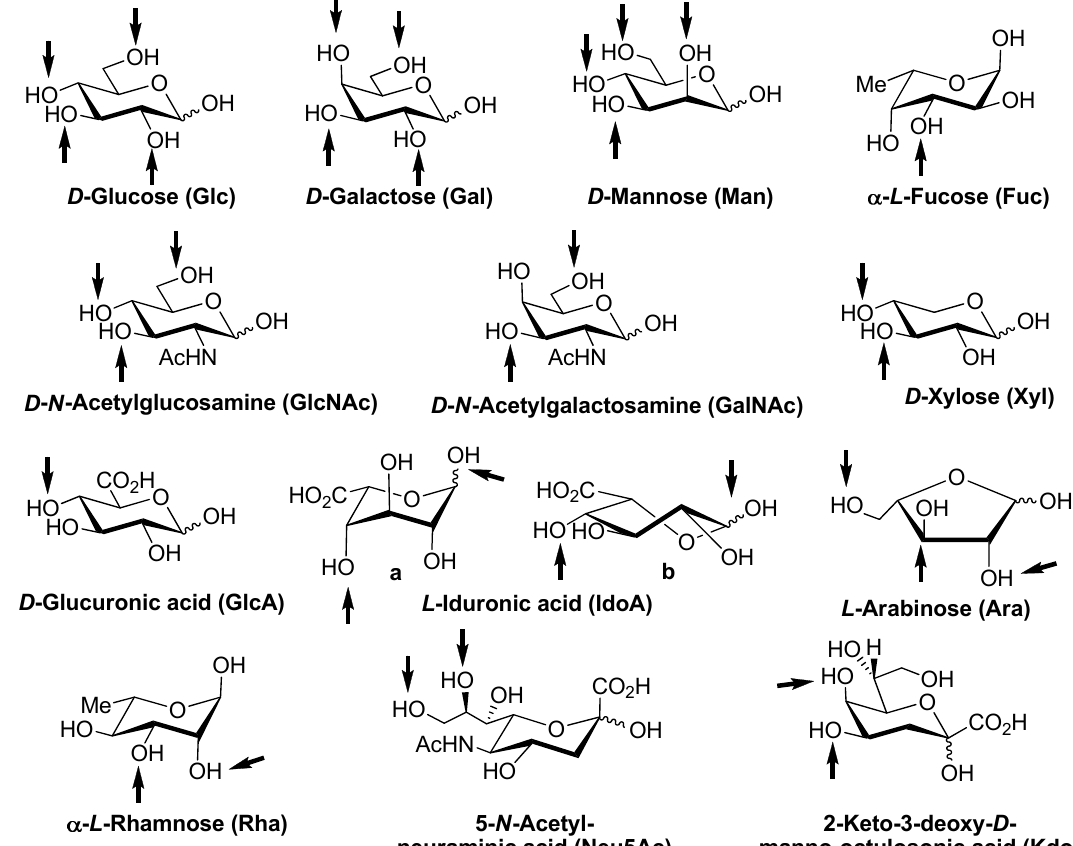
Figure 1. Illustration of the alphabet of the sugar language. Structural representation, name and symbol as well as the set of known acceptor positions (arrows) in glycoconjugates are given for each letter. Four sugars have L -configuration: fucose (6-deoxy- L -galactose), rhamnose (6-deoxy- L -mannose) and arabinose are introduced during chain elongation, whereas L -iduronic acid (IdoA) results from post-synthetic epimerization of glucuronic acid at C-5. The 1 C 4 conformation of IdoA ( a ) is in equilibrium with the 2 S 0 form ( b ) in glycosaminoglycan chains, where this uronic acid can be 2-sulfated. All other letters are D -sugars. Neu5Ac, one of the more than 50 sialic acids, often terminates sugar chains in animal glycoconjugates. Kdo is a constituent of lipopolysaccharides in the cell walls of Gram-negative bacteria and is also found in cell wall polysaccharides of green algae and higher plants. Foreign to mammalian glycobiochemistry, microbial polysaccharides contain the furanose ring form of D -galactose and also D / L -arabinose, then indicated by an italic “ f ” derived from the heterocyclus furan. The α -anomer is prevalent for the pentose arabinose, e.g., in mycobacterial cell wall arabinogalactan and lipoarabinomannan. β 1-5/6-Linked galactofuranoside is present in the arabinogalactan and the α 1-3/6 linkage in lipopolysaccharides (adapted from [15]).